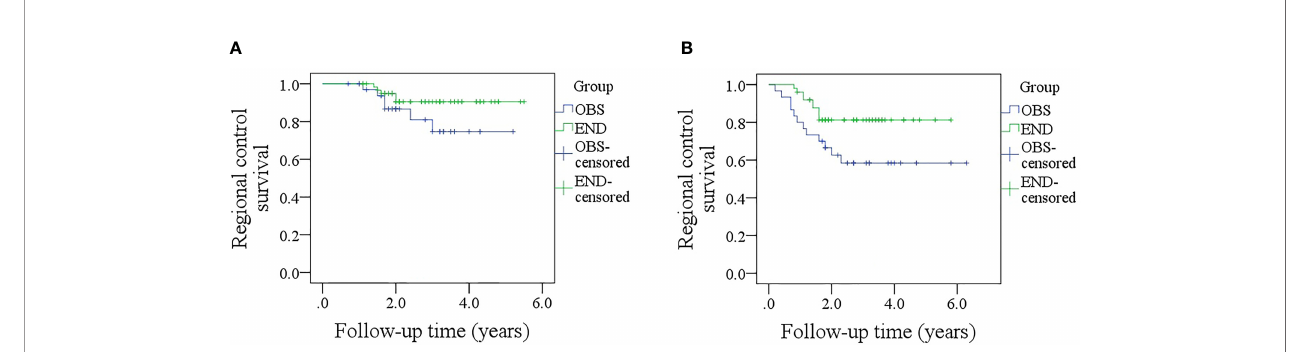
FIGURE 4 | (A) Comparison of regional control rates between the elective neck dissection and observation groups in patients with a sonographic depth of invasion <4.0 mm (p = 0.139); (B) Comparison of regional control survival between the elective neck dissection and observation groups in patients with a sonographic depth of invasion ≥ 4.0 mm (p